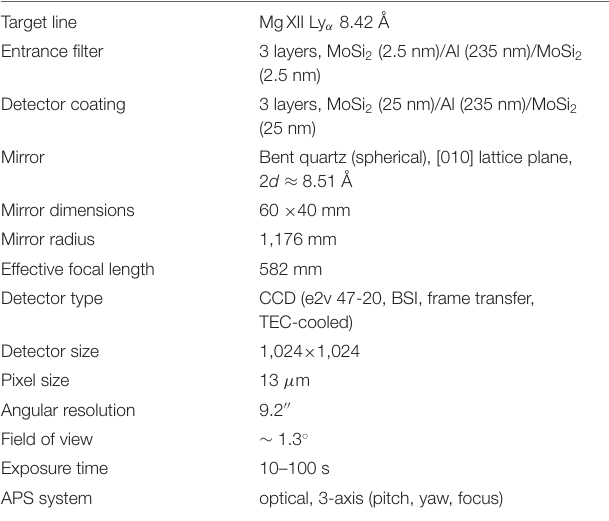
TABLE 4 | Main characteristics of monochromatic X-ray Bragg-crystal imager (MXI). Target